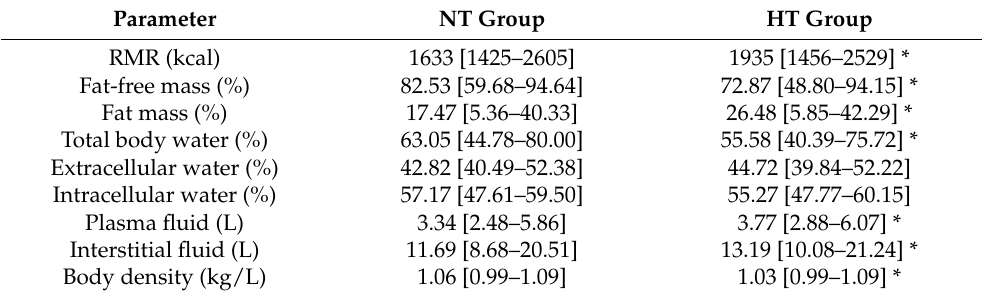
Table 3. Body composition and body fluid status of the subjects.